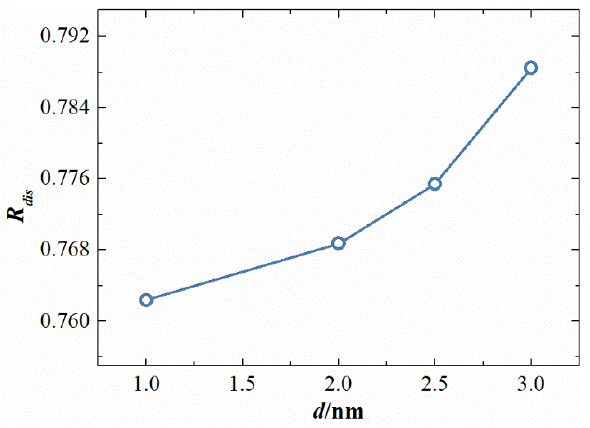
Figure 12. Displacement efficiency of CH 4 by CO 2 in different pore sizes.